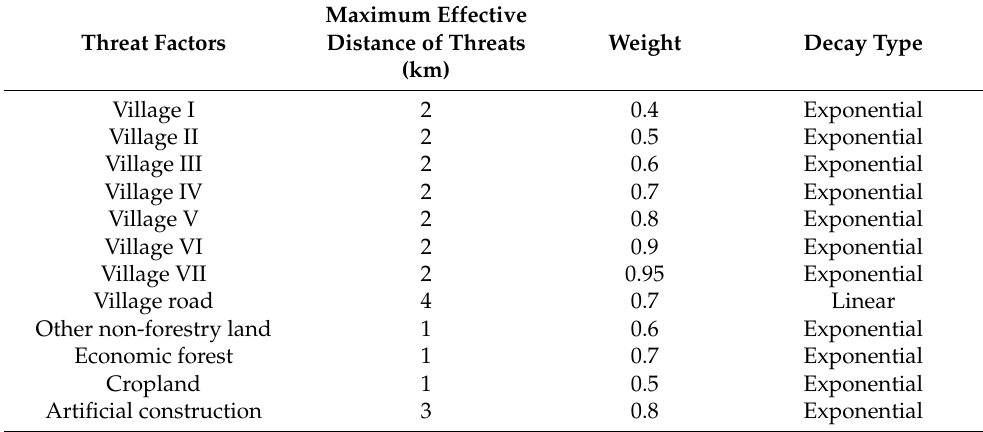
Table 5. The threat factors and related coefficients, including maximum effective distance of threats (km), weight, decay